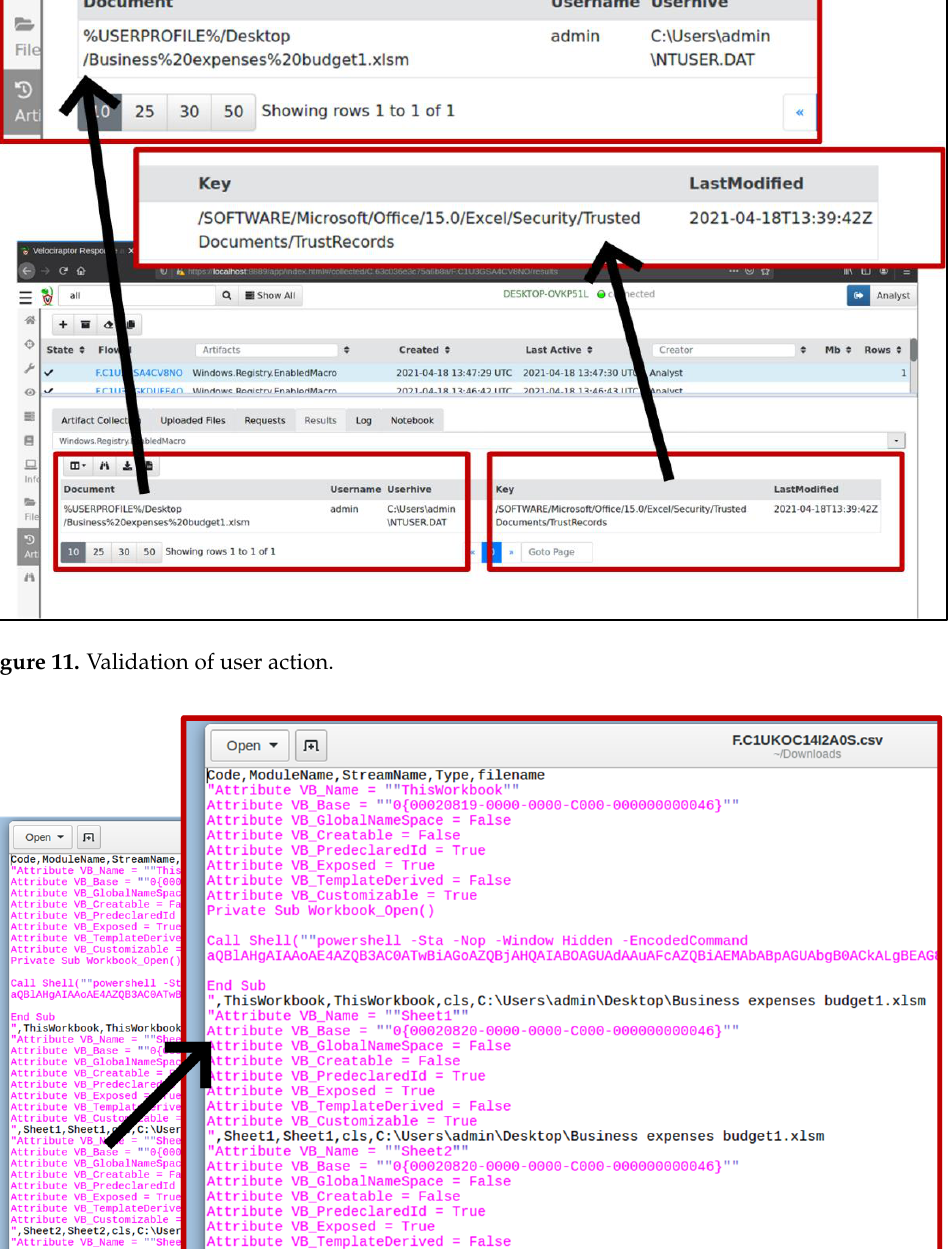
Figure 12. Macros are embedded in the